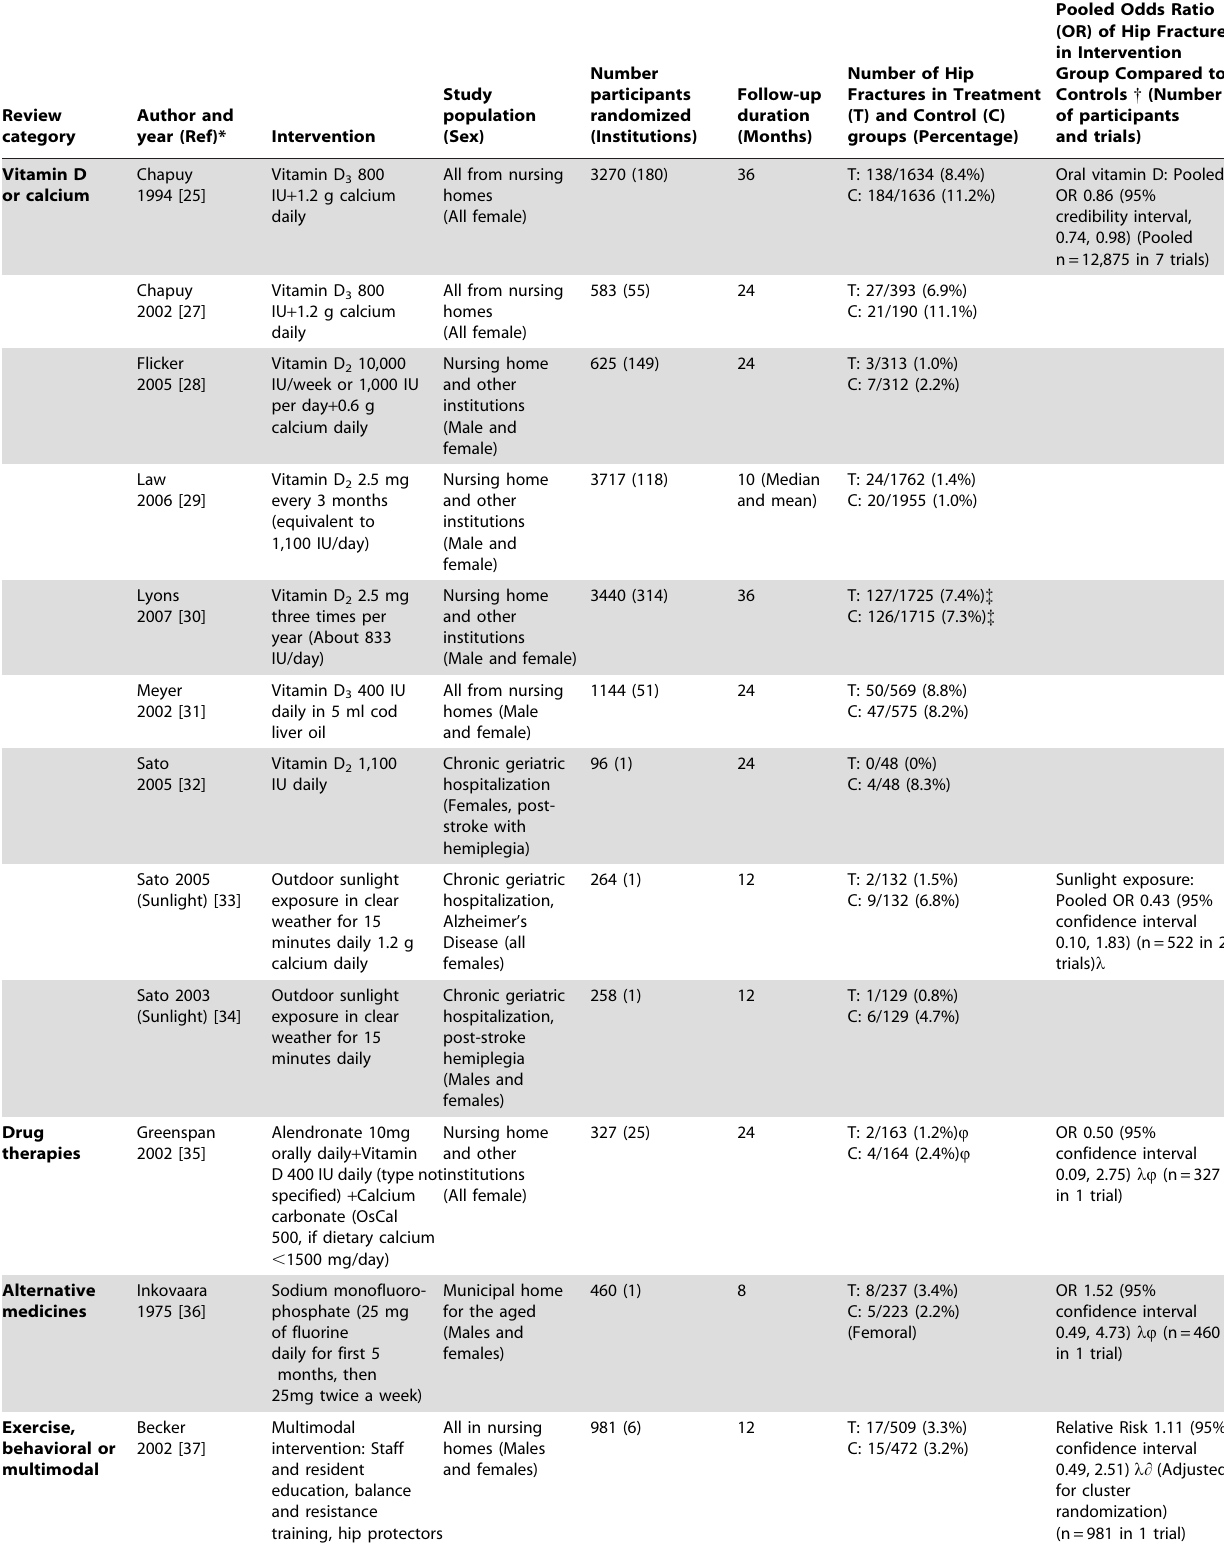
Table 2. Description of the included studies and pooled analyses.